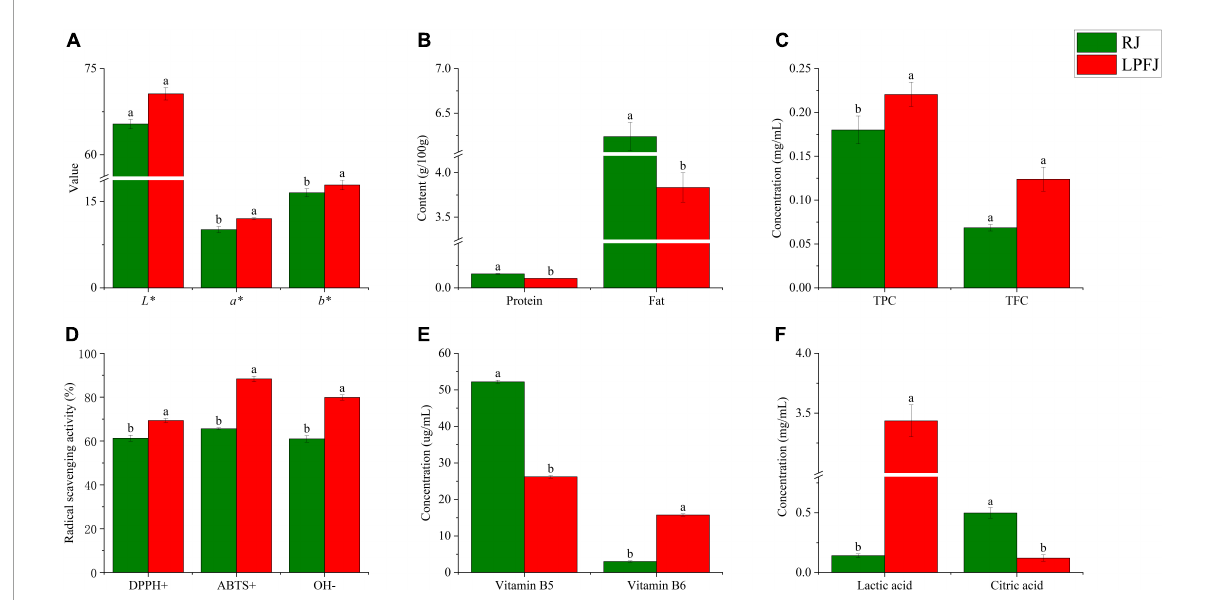
FIGURE1 Analysis of the physicochemical indicators of RJ and Lactobacillus plantarum fermented juice (LPFJ). Post-LAB fermentation change in panel (A) color properties of chickpea milk L ∗ (brightness), a ∗ (red-green), and b ∗ (yellow and blue), (B) protein and fat contents, and functional indicators including (C) TPC and TFC, (D) radical scavenging activity, (E) vitamin B5 and vitamin B6 contents, and (F) lactic and citric acids contents. Values marked with different superscript letters indicate statistically significant differences ( p < 0.05). RJ, raw juice; LPFJ, L. plantarum fermented juice; TPC, total phenol content; TFC, total fat